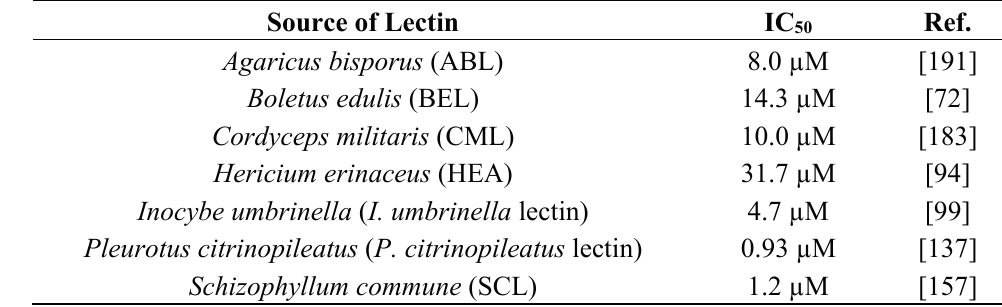
Table 4. Anti-HIV-1 reverse transcriptase activity of mushroom